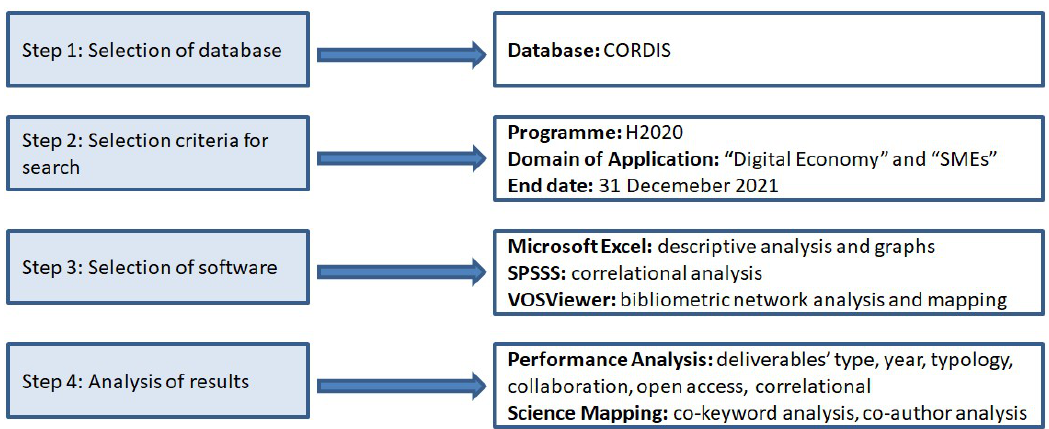
Figure 1. Phases of the methodology.